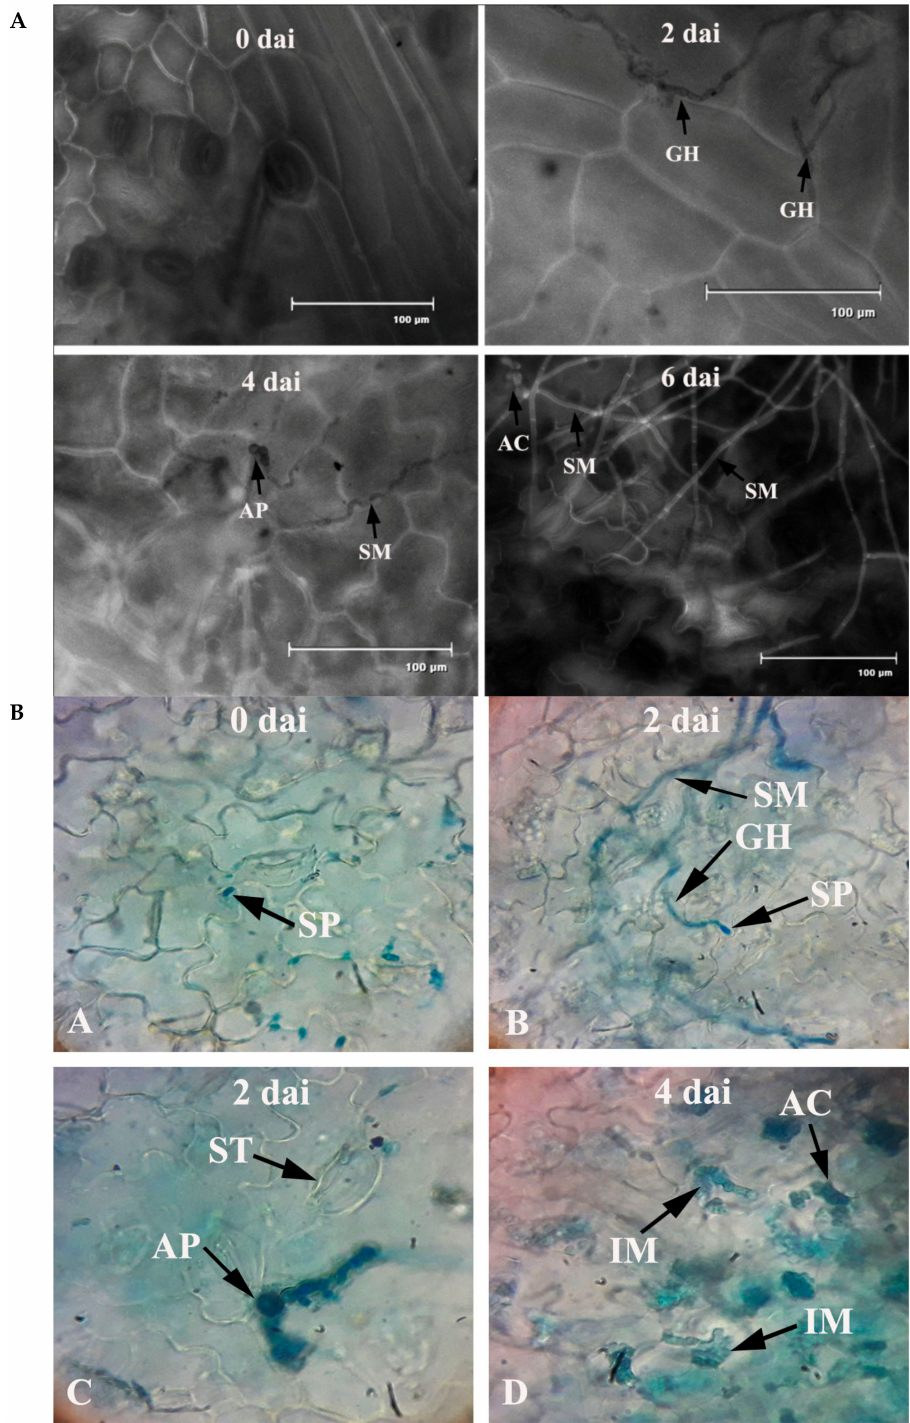
Figure 2. ( A ) Penetration and colonization of leaves of common bean by C. gloeosporioides . Note: GH = germinating hyphae; AP = appressorium; SM = surface mycelium; AC = acervuli; dai = days after inoculation. ( B ) Bright field images of penetration and colonization of leaves of common bean by C. gloeosporioides . Note: SP = spore; SM = surface mycelium; GH = germinating hyphae; ST = stomata; AP = appressorium; AC = acervuli; IM = intramural hyphae; dai = days after